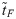
Dependence of critical time duration t~F on amplitude τ~m of a rectangular shear stress impulse.The solid curve corresponds to the dependence t~F(τ~m) obtained in the framework of developed approach (S4 Text for details). The dotted line τ~m=τ~# is a vertical asymptote of the curve t~F(τ~m). The curve t~F(τ~m) is asymptotically tending to the dashed curve with increasing τ~m. The values of t~F are measured in units of characteristic unfolding time t~0 (S4 Text). The value of CSS0 is given by Eq (16). All curves were built for the case of N = 36.